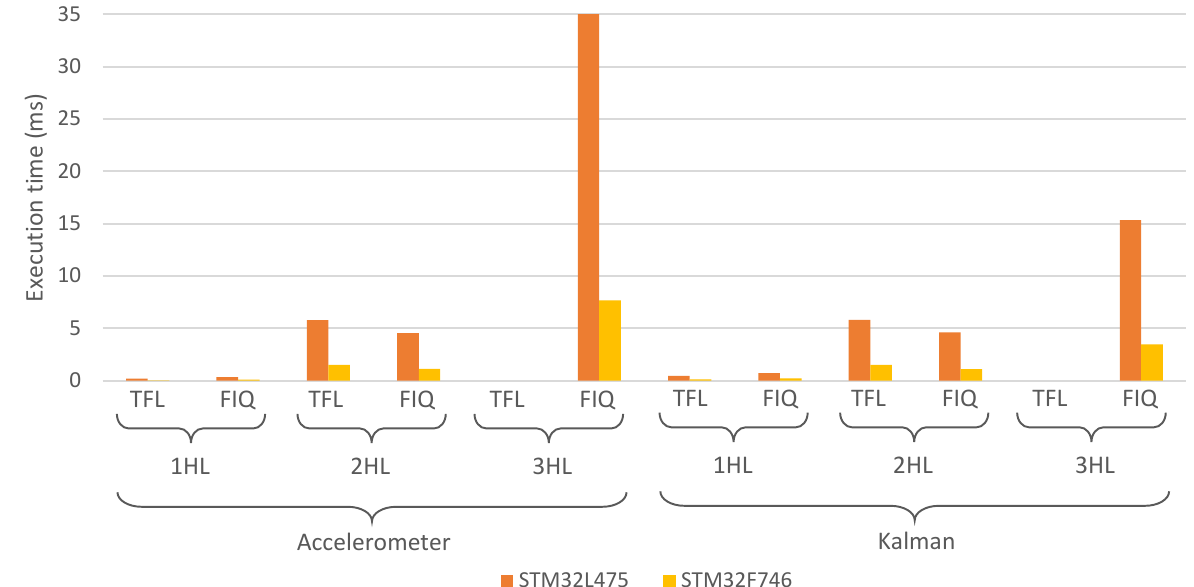
Figure 5. Execution time required for the ANN to perform a prediction for each of the two hardware platforms presented in Section 2.6.